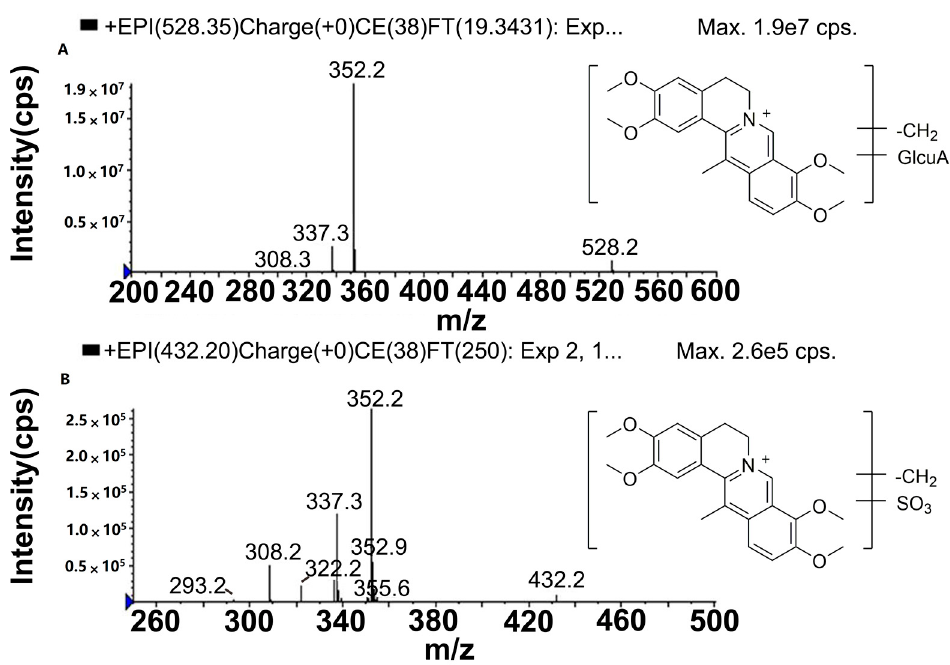
Figure 5. The mass spectrometry (MS 2 ) spectra of O -demethylated metabolites followed by glucuronidation ( A : M5, M6 and M7) and sulfation ( B : M8, M9 and M10).